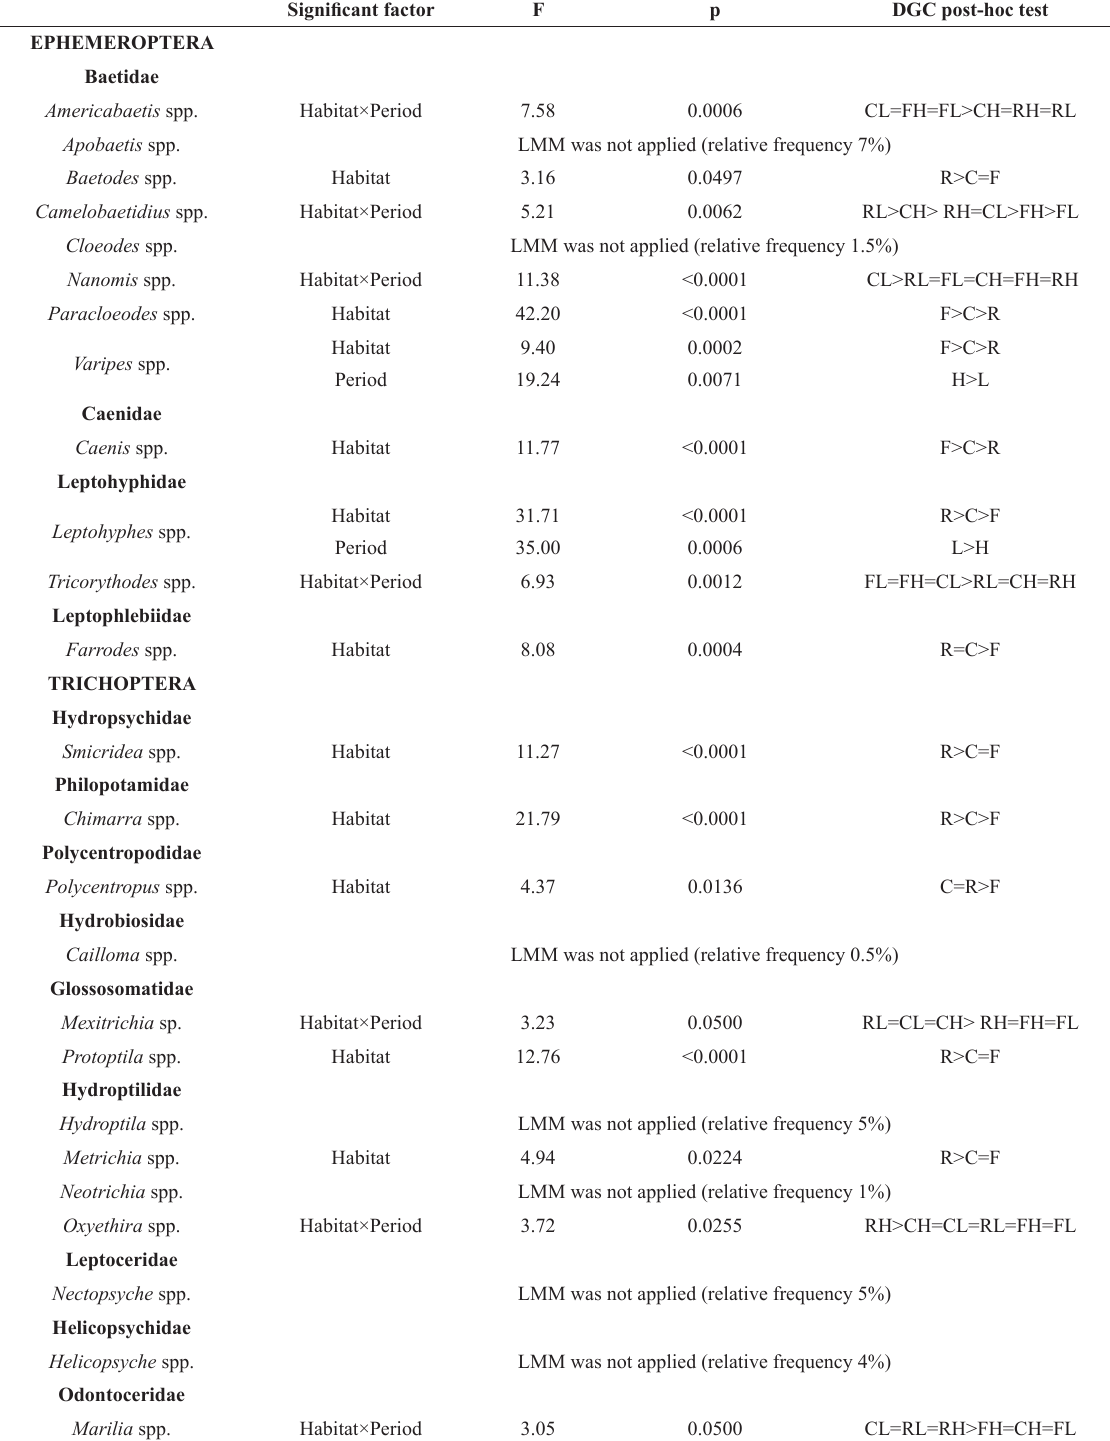
: Habitat , Period , Habitat×Period . DGC: Di (factor, error) (2, 192) (1, 192) (2, 192)